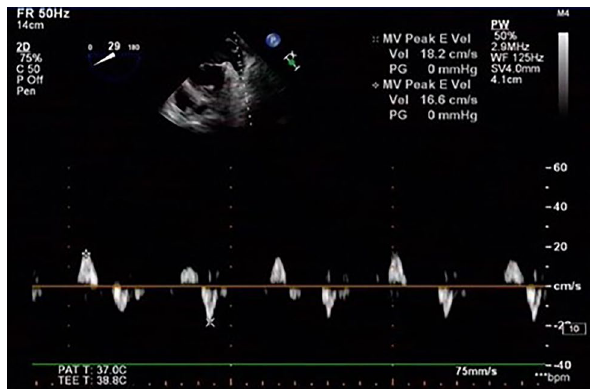
Figure 1. The blood flow pattern of the left atrial appendage in sinus rhythm.